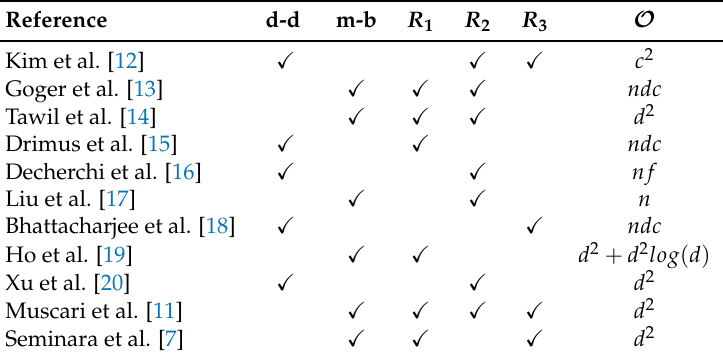
Table 1. Classification of selected contact modelling